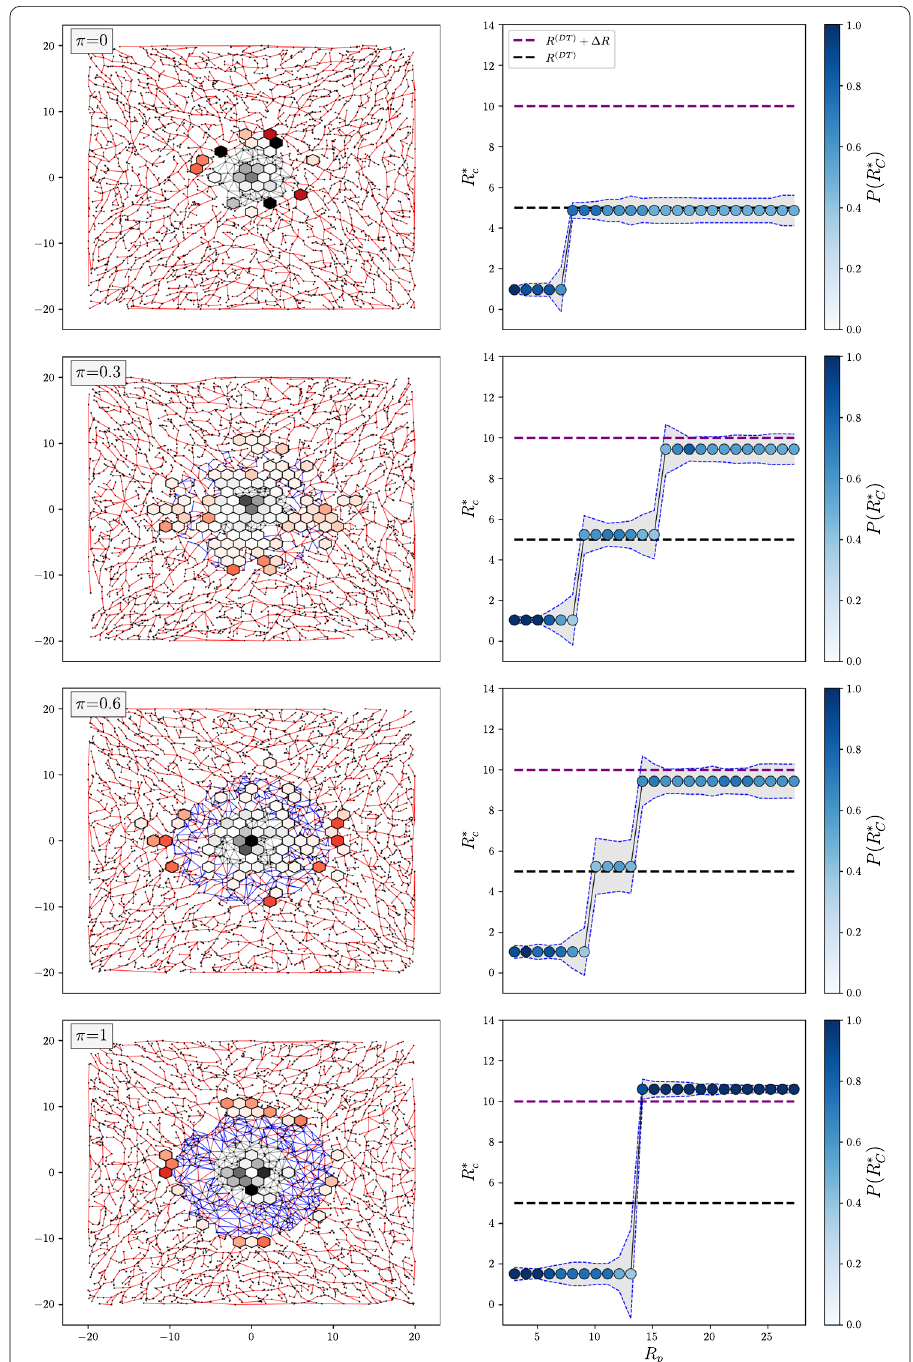
Fig. 4 Spatial behavior of the congestion nodes for the setup introduced in “Center‑periphery entanglement with spatial overlap” section. The figure is organized similarly to Figs. 2 and 3: left panels show the network configurations, where blue edges refer to the π density of further DT links we add on top of the MST skeleton in the [ R , R + (cid:31) R ] hybrid region. Still, hexagonal bins describe the occurrence of congestion in space. Right panels presents the dependence of congestion radius on the patch one. Here, circles are located at the statistical mode over an ensemble of 100 realizations of different random distributions of N = 3000 nodes in a square of side equal to L = 20 , with R ( DT ) = 5 , and (cid:31) R = 5 . The figure highlights the emergence of a further intermediate congestion regime, as a consequence of the hybrid region marked in